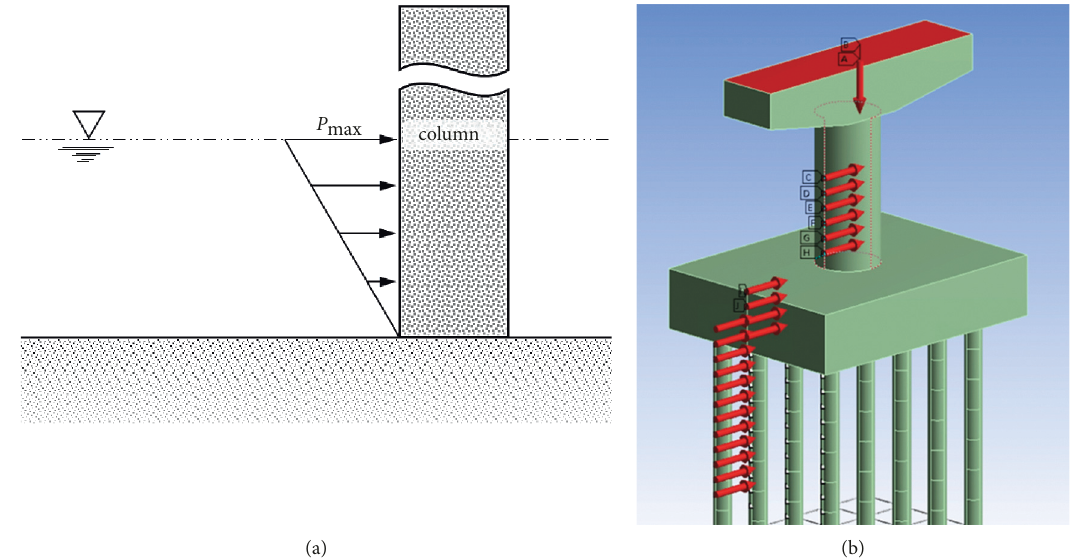
Figure 17: Static loading simulation. (a) Vertical current pressure distribution. (b) Setting of lateral current